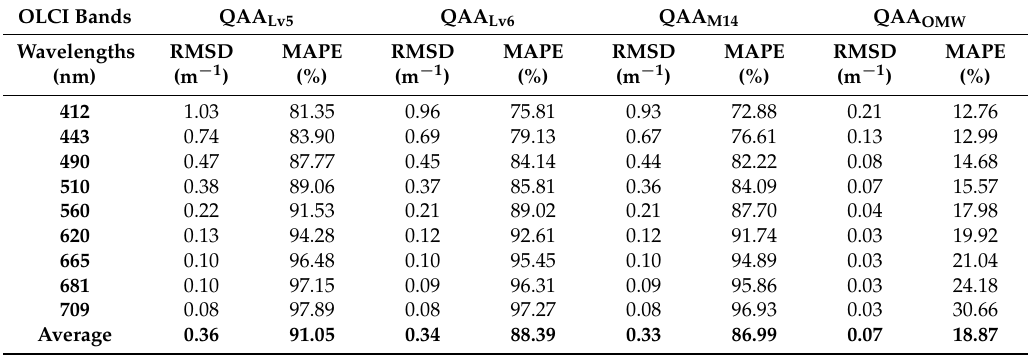
Table 5. Comparative band-specific errors related to the re-parameterization of a CDM ( λ ) based on MAPE (%) and RSMD (m − 1 ) metrics. The first column represents the nominal OLCI center bands (nm). OLCI Bands